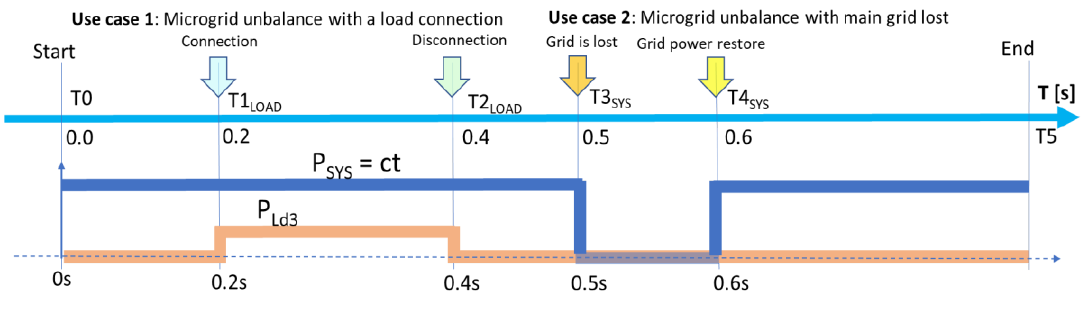
Figure 6. The simulated sequence of events.